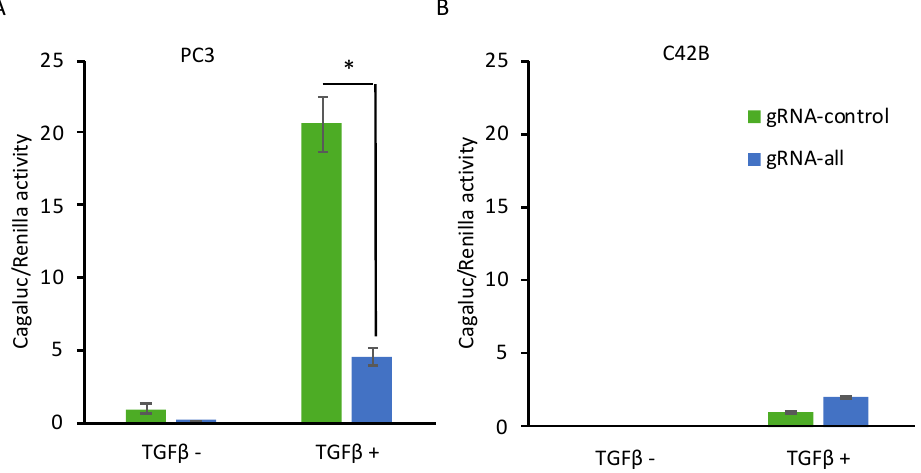
Figure 3. CRISPR-mediated induction of Dkk-3 inhibits TGF-β signaling in PC3 cells. ( A , B ) Gene reporter assays using PC3 ( A ) and C4-2B ( B ) cells transfected with CAGA12-luciferase, renilla, dCas9- VPR and either gRNA-control (gRNA-C) or DKK3 gRNAs (gRNA-all). TGF-β1 (2 ng/mL) was added 24 h after transfection and reporter activity was measured after 24 h. Graphs show mean CAGA luciferase/renilla activity, relative to untreated gRNA-control cells. * p < 0.05, two-tailed Student’s t - test, n = 3.